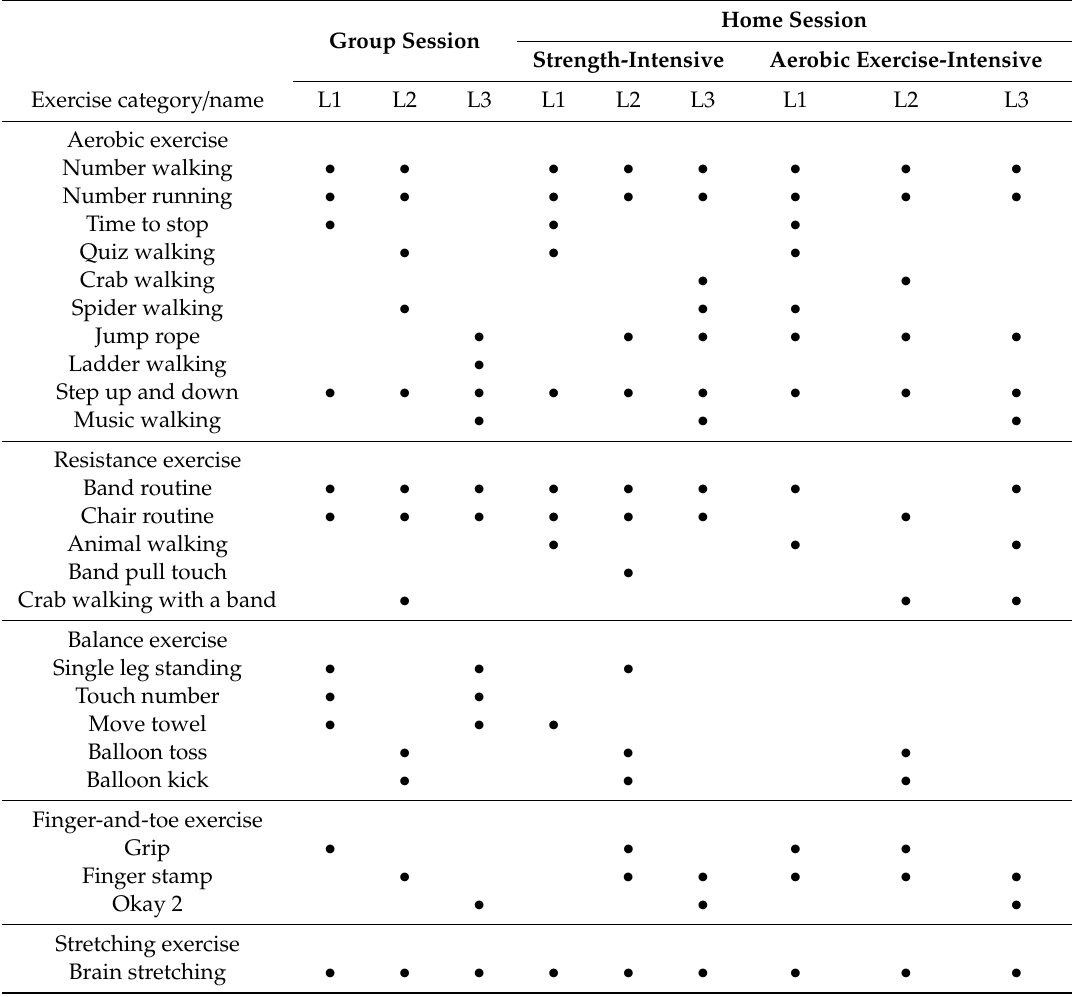
Table A1. Detailed description of